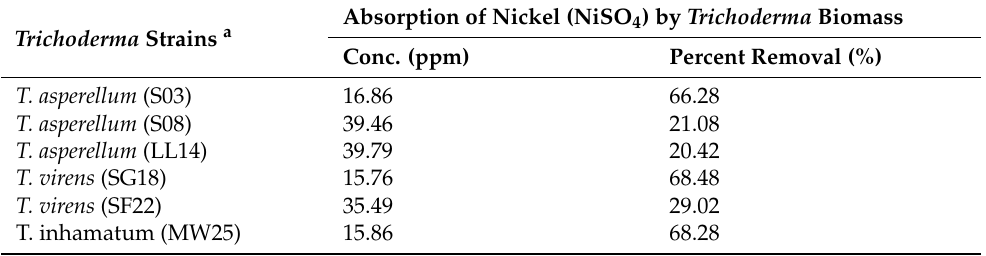
Table 3. Nickel uptake efficiency of the six Trichoderma isolated from marine and terrestrial substrates. Absorption of Nickel (NiSO 4 ) by Trichoderma Biomass Trichoderma Strains a Conc.